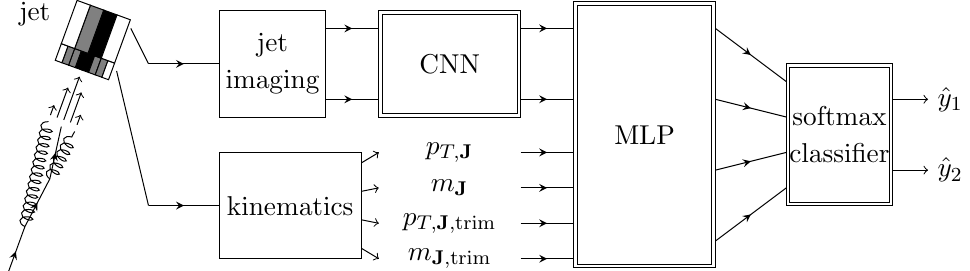
Figure 21 . A schematic diagram of a convolutional neural network trained on jet image. The double bordered boxes represent trainable